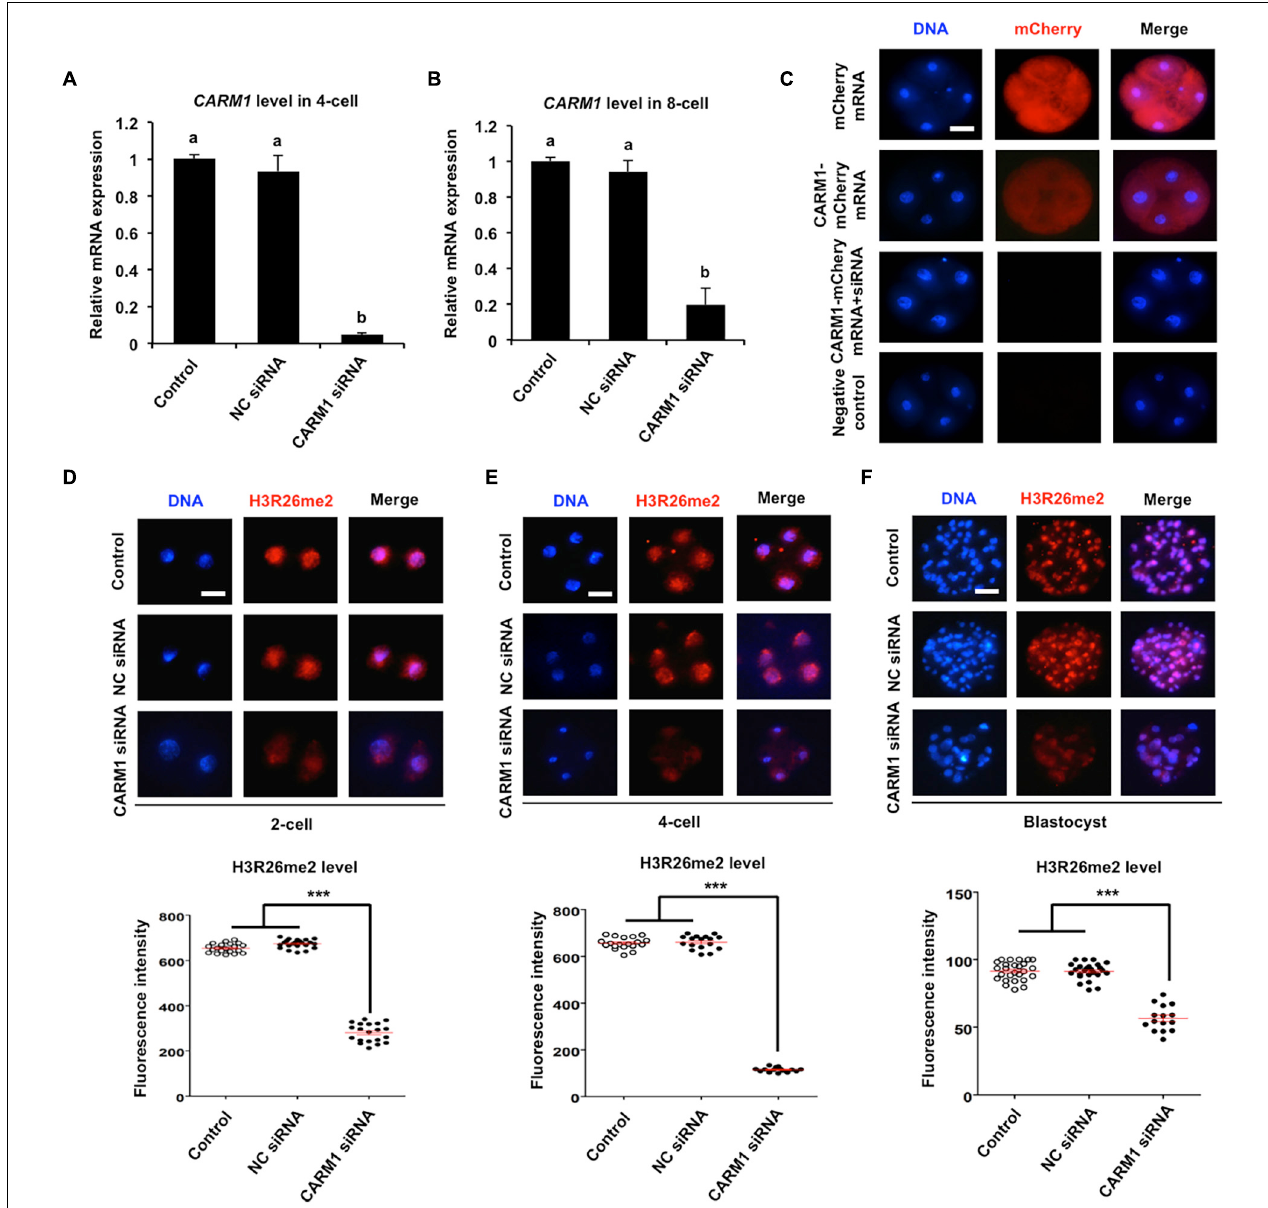
FIGURE 3 | Effect of siRNA injection on CARM1 expression and H3R26me2 levels in embryos. Expression levels of CARM1 mRNA in 4-cell (A) and 8-cell (B) from control, NC siRNA injection, and CARM1 siRNA injection were determined by qPCR. NC, negative control. (C) Expression of CARM1 protein in 4-cell embryos. Embryos from the indicated groups were imaged for mCherry (red) and DNA (blue) by confocal microscopy and the representative images are shown. The experiment was independently repeated three times with at least 20 embryos per stage. Scale bar: 50 µ m. Effect of siRNA injection on H3R26me2 levels in 2-cell (D) , 4-cell (E) , and blastocysts (F) . Embryos at different stages were stained for H3R26me2 (red) and DNA (blue). The experiment was independently repeated three times with at least 15 embryos per group. Scale bar: 50 µ m. All data are shown as mean ± S.E.M and different letters on the bars or asterisks indicate significant differences ( P <